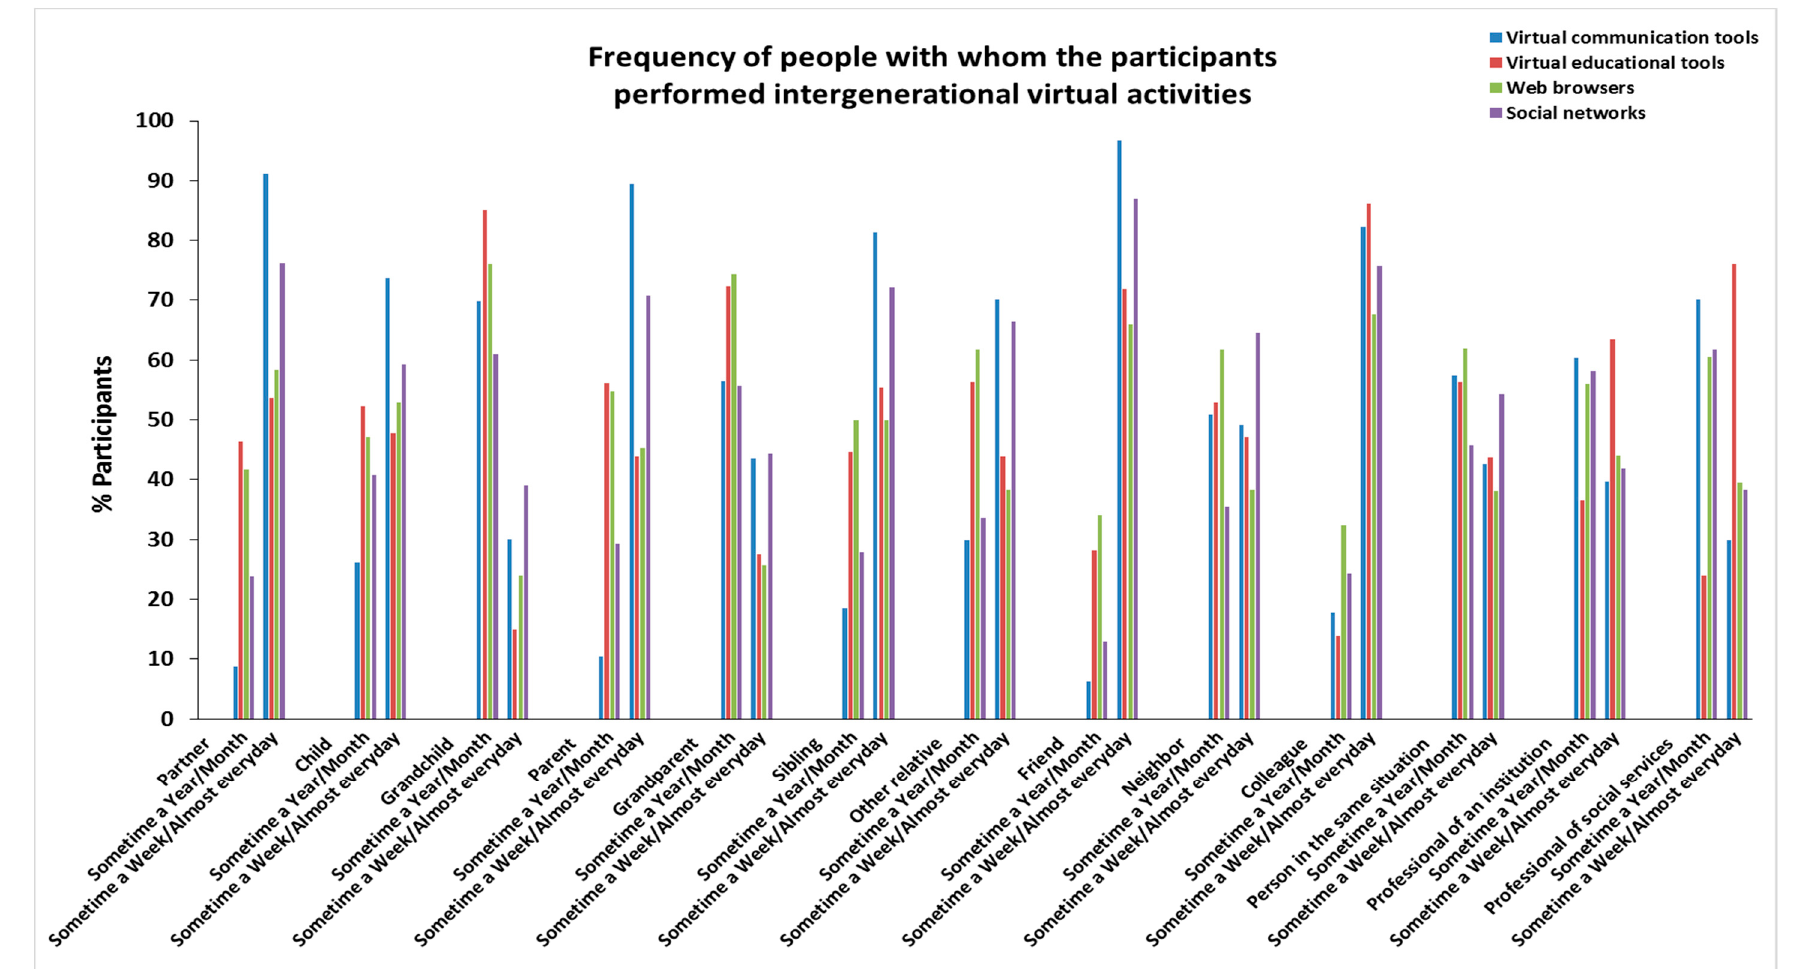
Figure 4. Frequency of people with whom the participants performed intergenerational virtual activities.